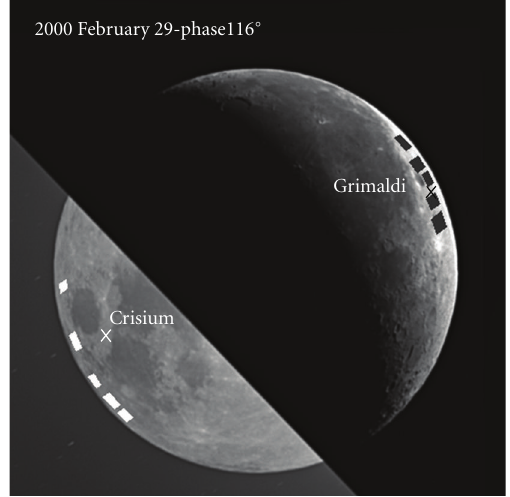
Figure 1: The moon showing the brightside and the earthshine. The Grimaldi side is in the moonshine (brightside) and the Crisium side is in the earthshine. Our ten highlands fiducial patches used in the observations made from BBSO are indicated. The crosses give the approximate positions of Danjon’s [3, 4] fiducial patches. Goode et al. [11] used one fiducial patch on each side, and on the Crisium side it is the one closest to the white cross, while on the Grimaldi side, it is the one immediately above the black cross. In the image, the lunar phase is 115 ◦ .9, near a declining quarter moon. Unlike the moonshine, the earthshine is flat across the disk. The flatness is due to the uniform, incoherent back-scattering (non-Lambertian), in contrast to the forward scattering of sunlight occurring in the sunlit lunar crescent surface.